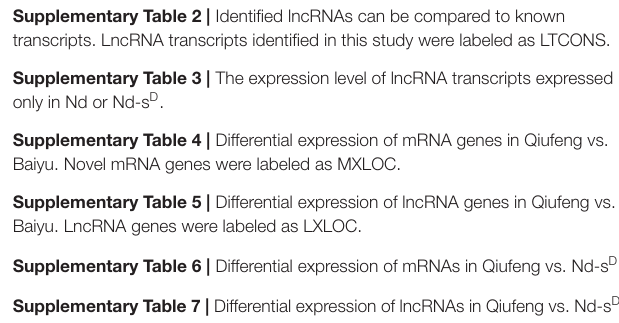
Supplementary Table 8 | Differential expression of mRNAs in Qiufeng vs. Nd. Supplementary Table 9 | Differential expression of lncRNAs in Qiufeng vs. Nd. Supplementary Table 10 | DEGs associated with protein proteolysis and programmed cell death. Supplementary Table 11 | Prediction results of lncRNAs may function as miRNA precursors. Supplementary Table 12 | The potential target genes of lncRNAs acting in cis/trans.